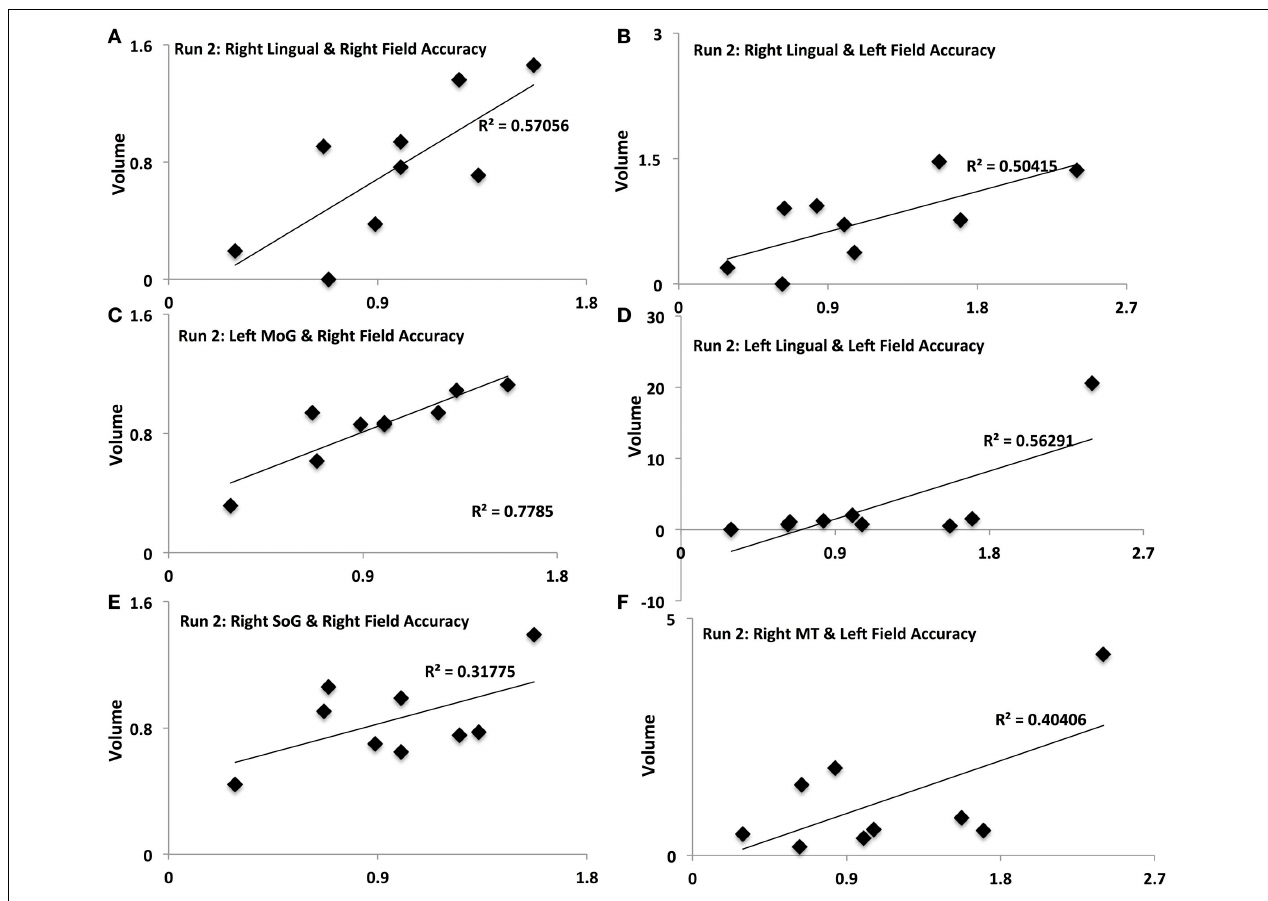
FIGURE 5 | Activation-accuracy relationships for other ROIs. Figure shows relationship between accuracy in contralateral and ipsilateral fields in run 2 and volumes of activation of occipito-temporal ROIs. Note that accuracy in each hemifield is represented as accuracy following rTMS normalized to that following sham. Similarly, volume of activation of an ROI or its intensity is computed as that following rTMS vs. that following sham. Pearson’s r values are listed in Table 2 .